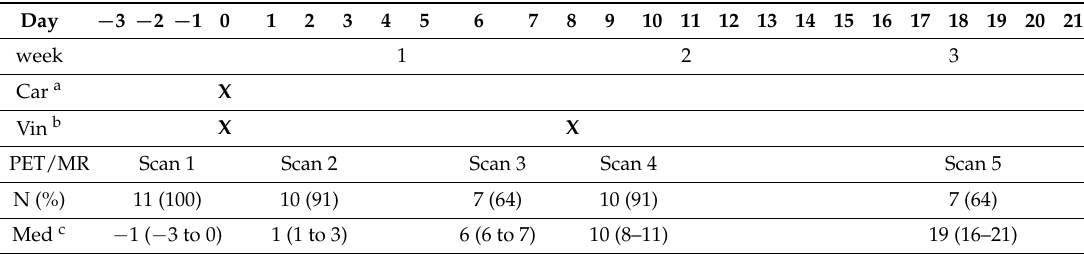
Table 2. Timing and completion of chemotherapy and PET/MR scans.